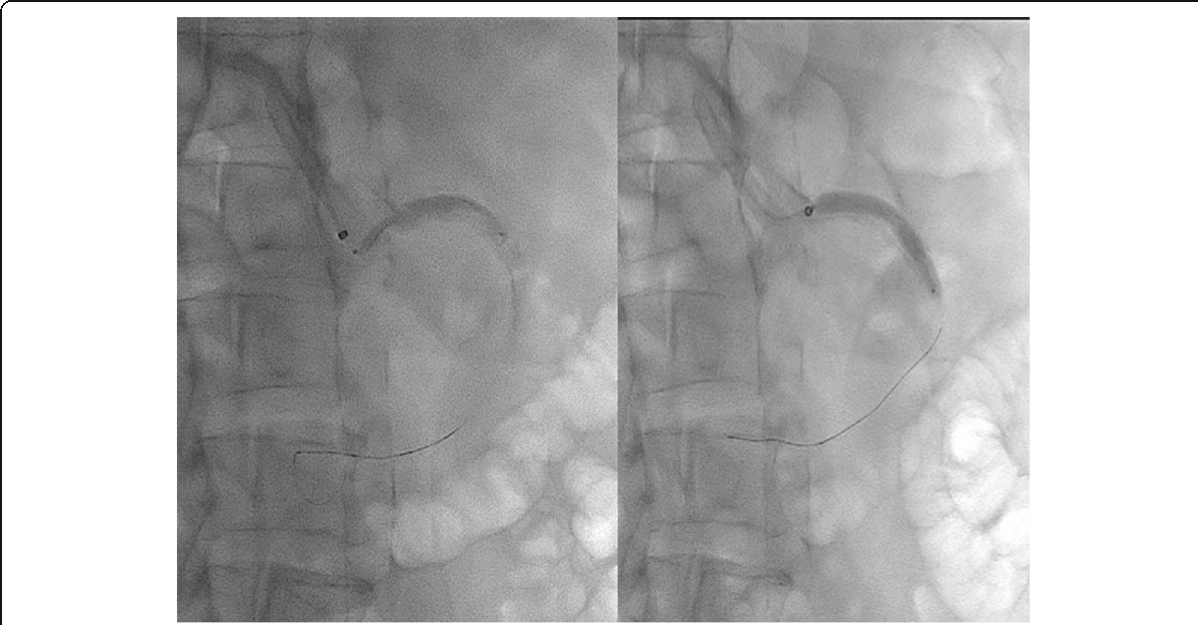
Fig. 2 Shockwave Lithotripsy M5 – 6 × 60 mm, balloon catheter placed first through the SMA ostium, and total subsequent coverage of stenosis. Balloon inflated to 4 atm during energy